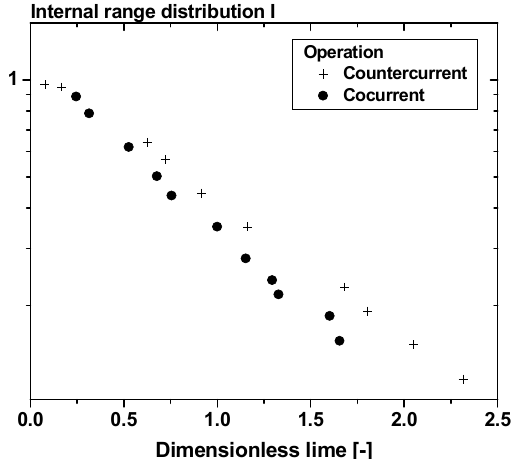
Figure 4. A hydrodynamics study during electroflotation: internal age distribution function of the effluent. Reprinted with permission by Taylor and Francis [45] .